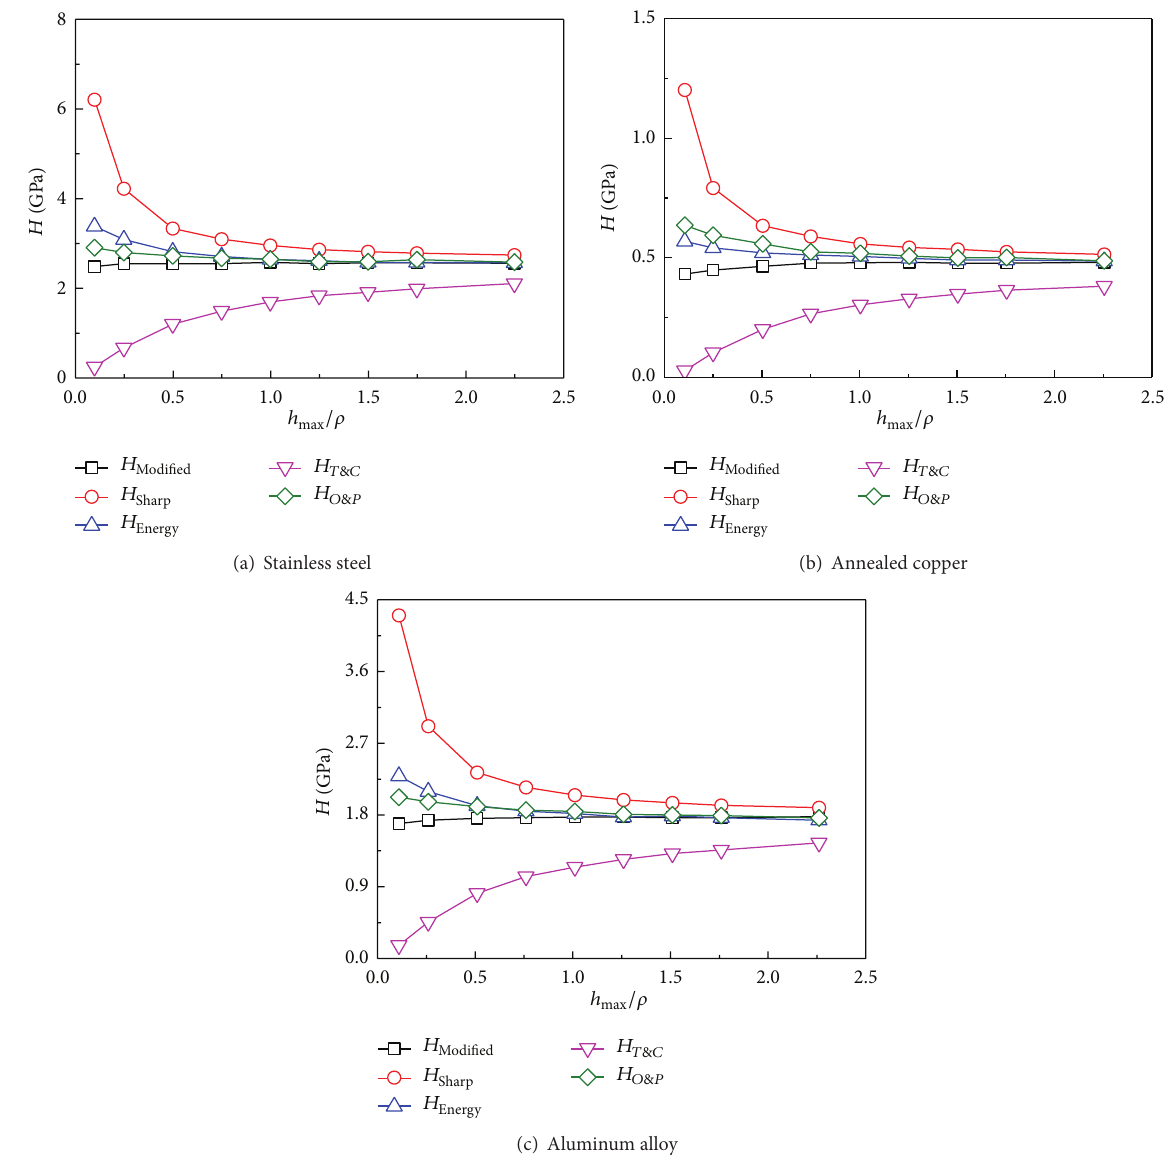
Figure 5: The hardness of materials determined by different